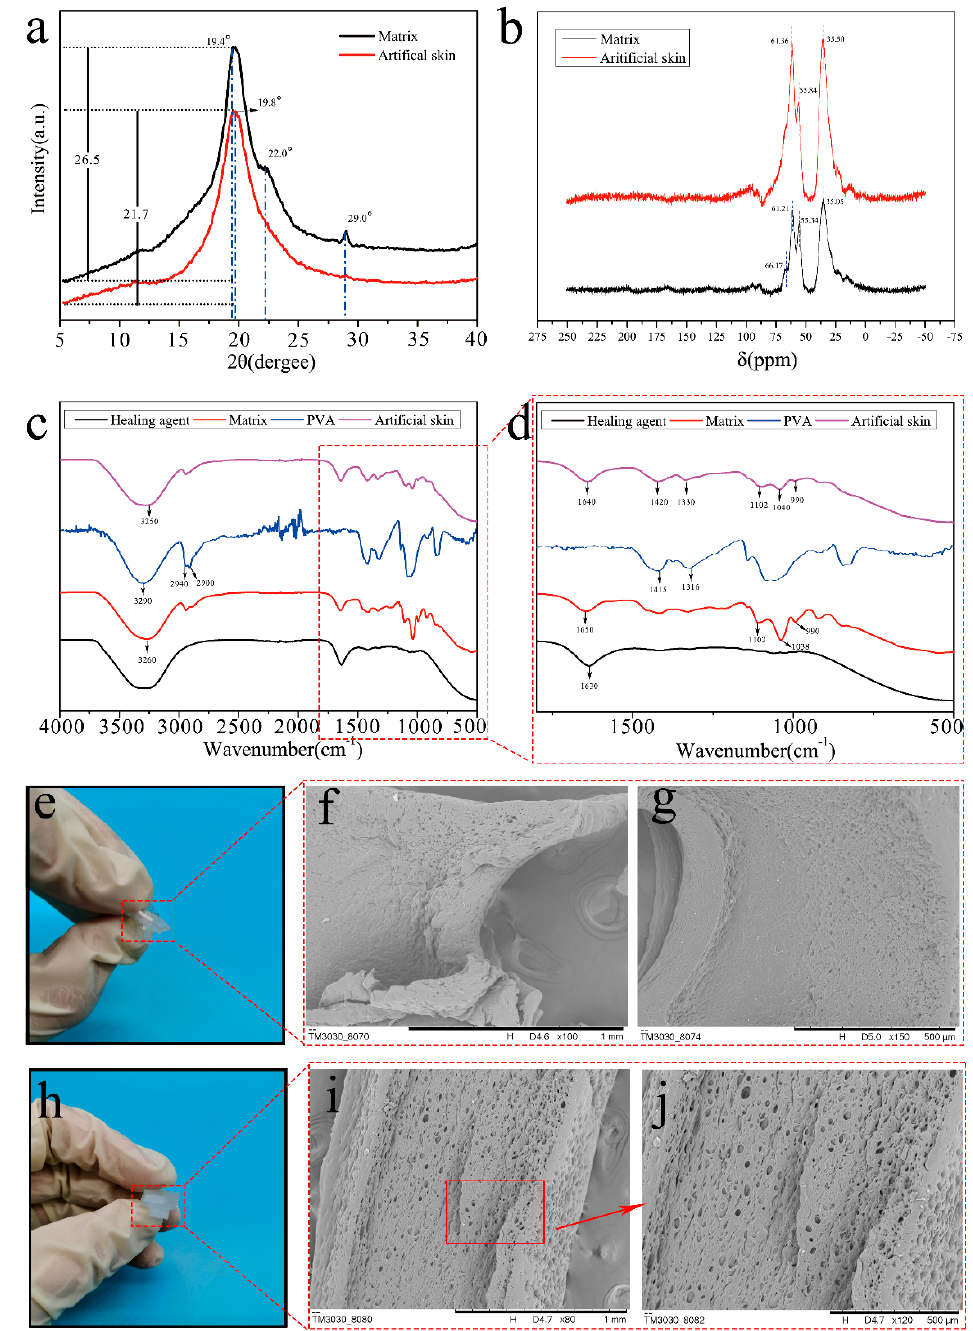
Figure 6. Tests of samples from the fracture surface of artificial skin and matrix samples. ( a ) XRD pattern of artificial skin and matrix. ( b ) C13-NMR curves of artificial skin and matrix. ( c , d ) FT-IR curves of artificial skin, matrix, PVA, and healing agent. ( e ) Artificial skin sample after tensile fracture. ( f , g ) SEM images of fracture surface of artificial skin. ( h ) Matrix sample after tensile fracture. ( i , j ) SEM images of fracture surface of matrix.